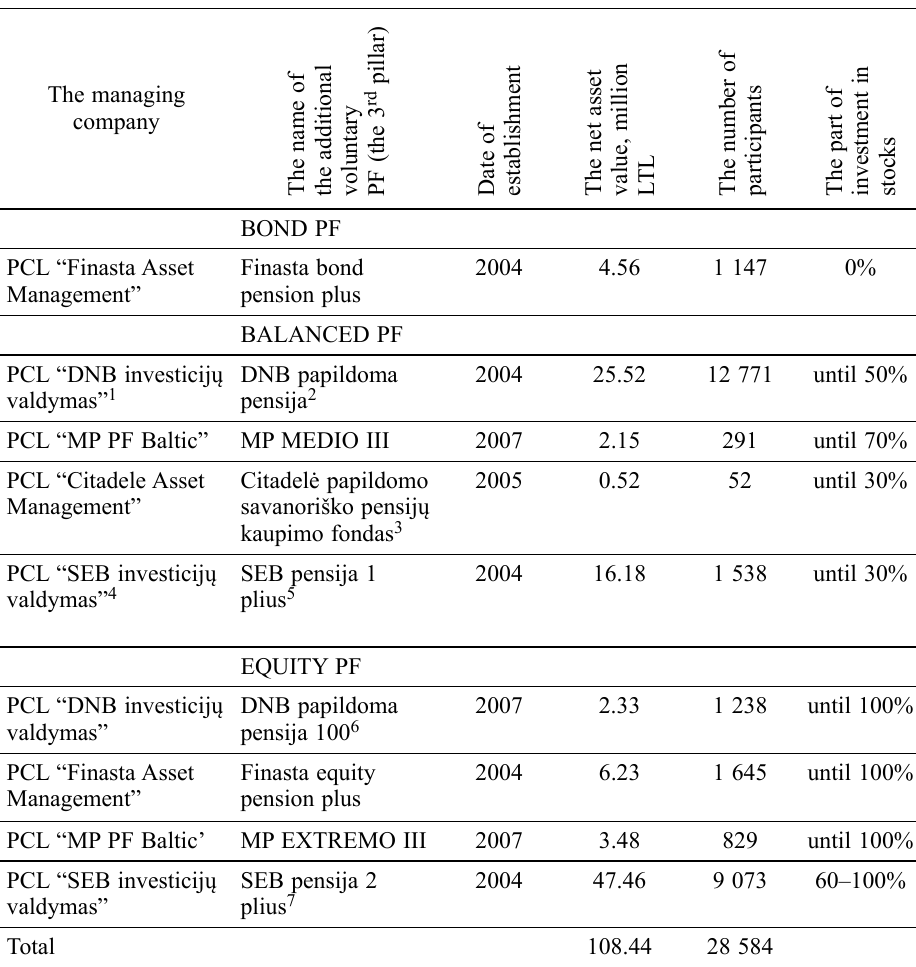
Table 4. Lithuanian 3 rd pillar PF data,